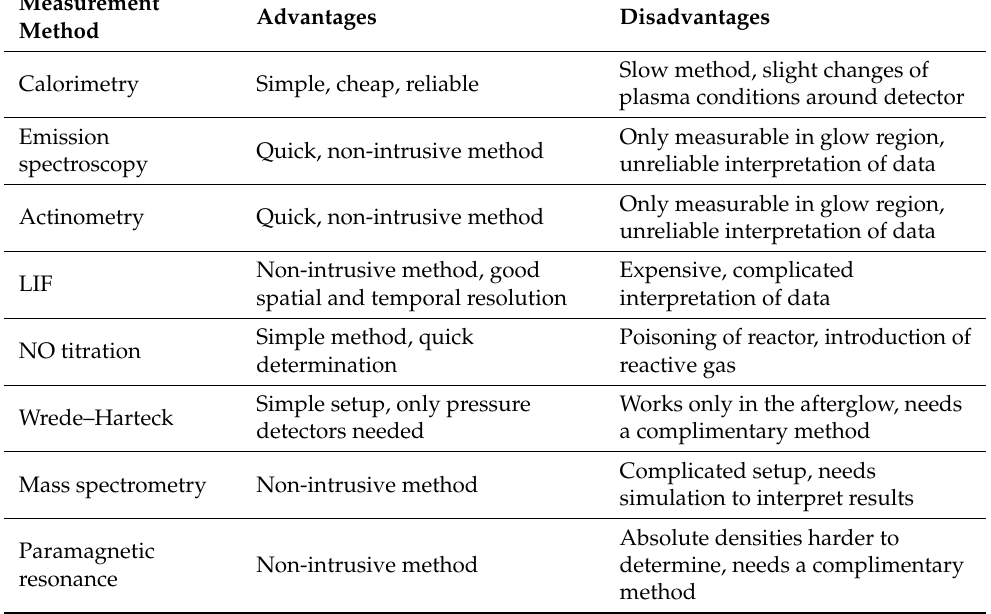
Table 3. Advantages and disadvantages of various types of measuring methods for determination of the neutral atom density and recombination